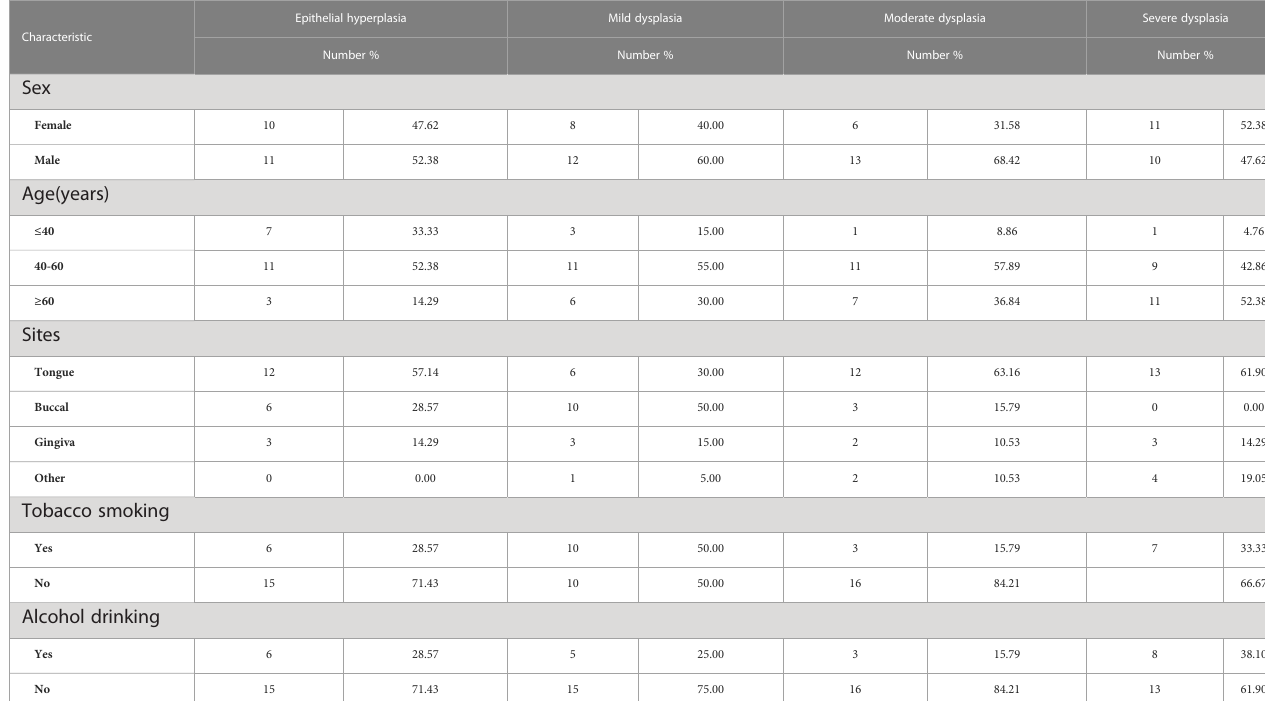
TABLE 2 Baseline characteristics of the patients in stable